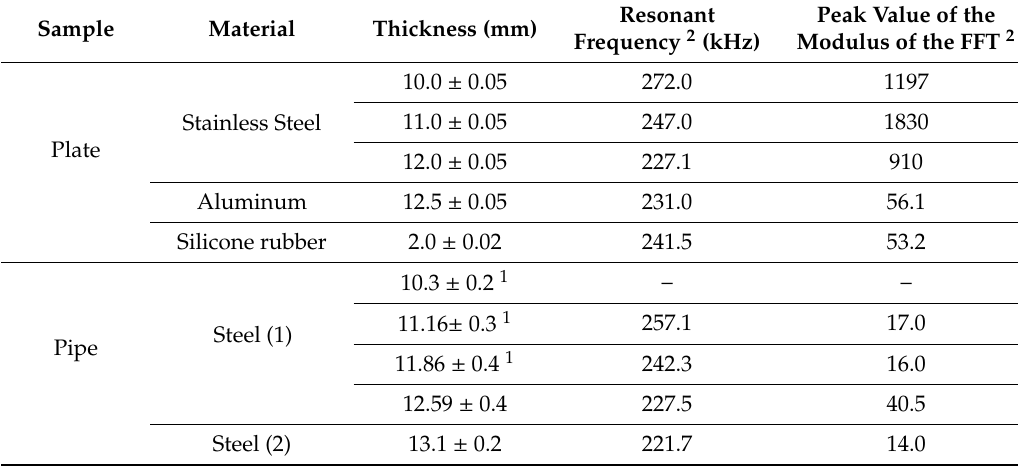
Figure 9. FFT modulus of the signal received from the three stainless steel plates in pulse-echo. Red ( f res = 227.5 kHz): 12 mm-thick plate, Green (f res = 247.0 kHz): 11 mm-thick plate, and Blue ( f res = 272.0 kHz): 10 mm-thick plate. FFT window: t 0 = 10 ms, ∆ t = 7 ms. Table 4. Pulse-echo resonant frequency and peak